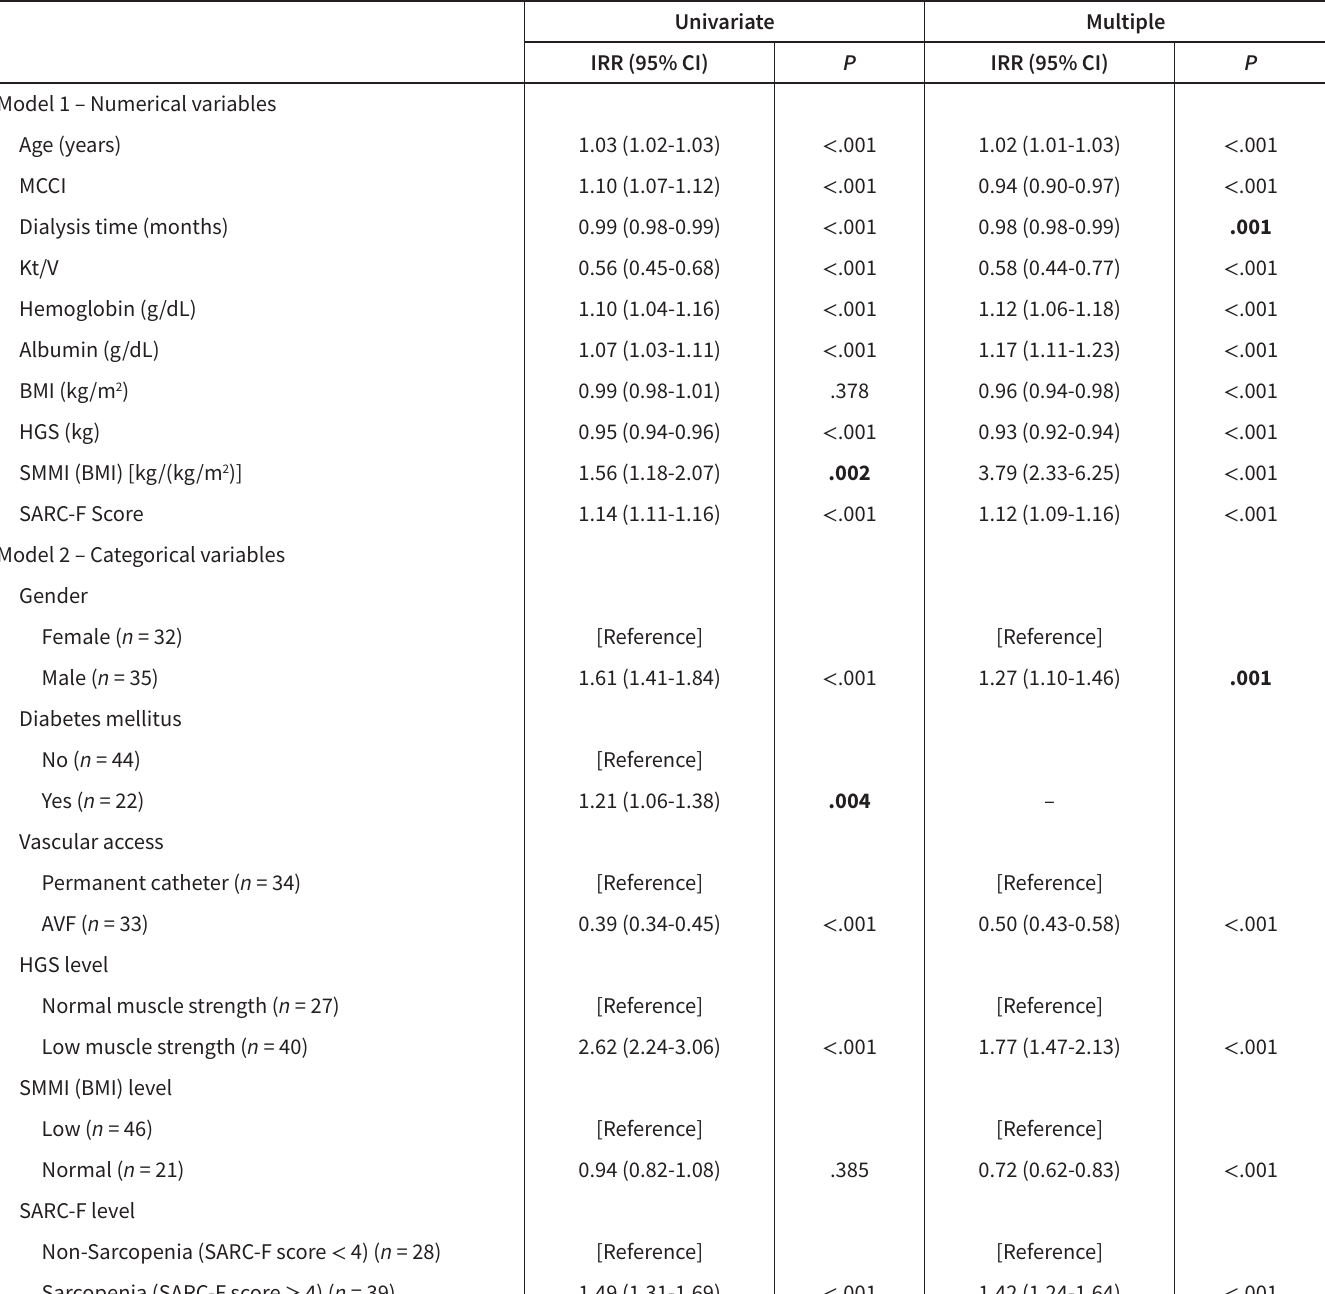
Table 3. Evaluation of Risk Factors for Length of Stay in Hospital in Hemodialysis Patients by Univariate and Multiple Poisson Regression